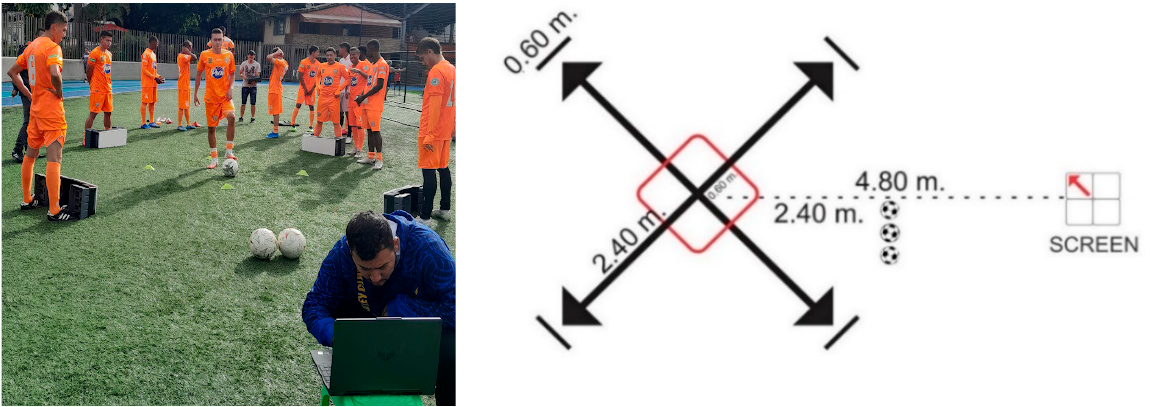
Figure 3. Characteristics of the surface where the test was executed. Regarding the direction, move- ments were executed on a surface demarcated by four arrows, where their intersection was the start- ing point. From the center to the periphery (tip of the arrows), there was a distance of 2.40 m,